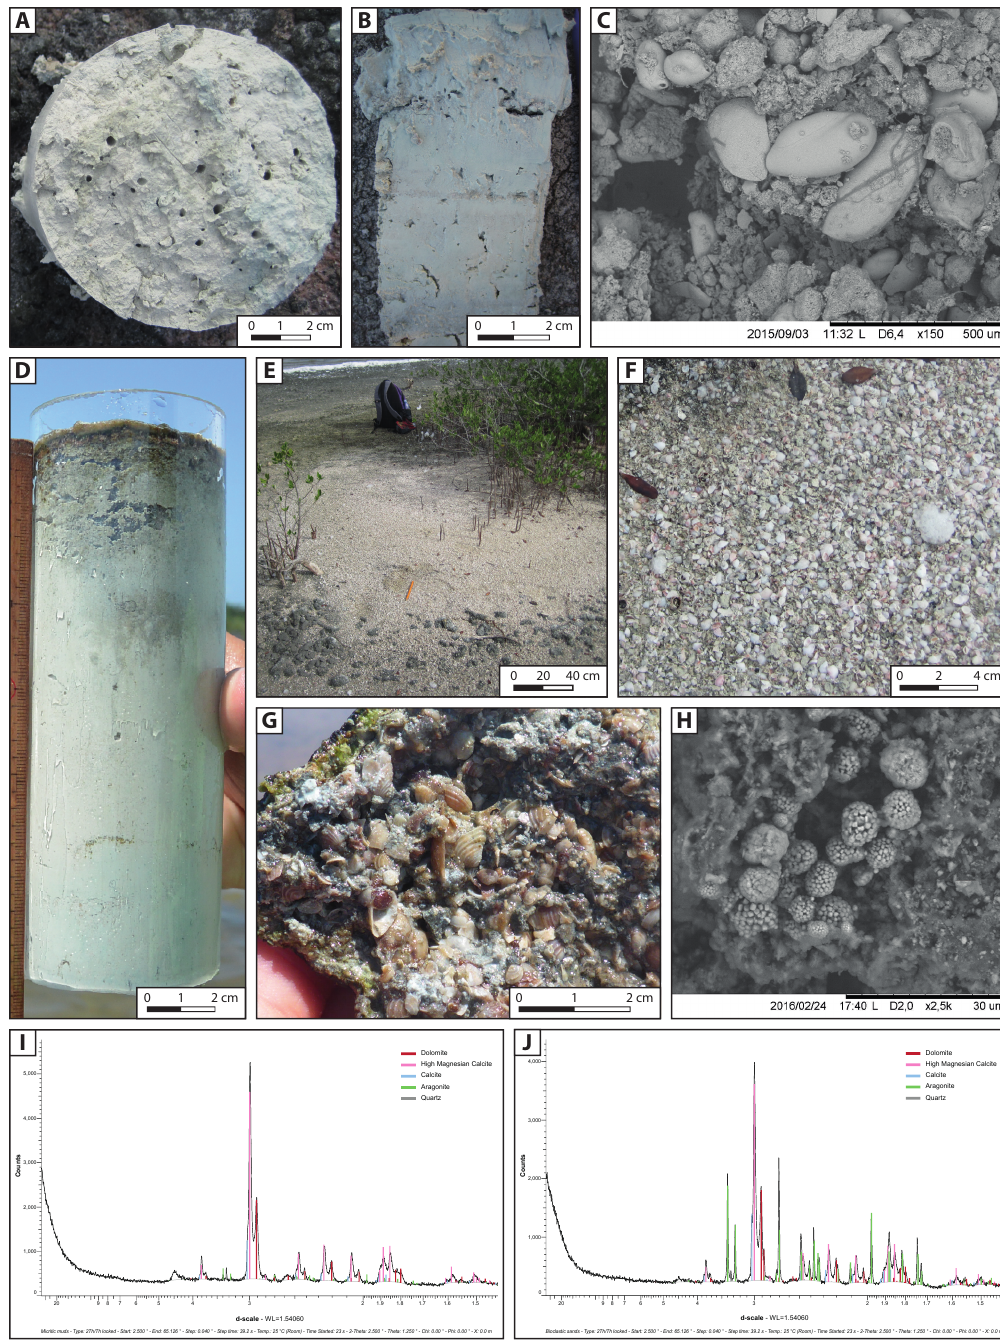
Figure 3. ( A ) Horizontal surface and ( B ) vertical sections of a core sampled within micritic muds, with root traces. ( C ) SEM image from the micritic muds depicting mud-sized carbonate grains associated with bioclasts (e.g., foraminifers). ( D ) View of Core CC-1 just after removal in the field. This core mainly consists of micritic muds below the surface microbial mat. ( E ) Bioclastic sands deposited along the lagoon shore covering the hemispheroid microbial mats. ( F ) Zoomed-in image of the bioclastic accumulation, mostly composed of disarticulated and fragmented bivalves ( A. auberiana ). ( G ) Bioclastic accumulation embedded in a micritic matrix on which a mineralising microbial mat has developed. ( H ) SEM image of framboidal pyrites observed within the micritic muds. (I and J) X-Ray di ff ractometric spectrums of micritic muds ( I ) and bioclastic sands ( J